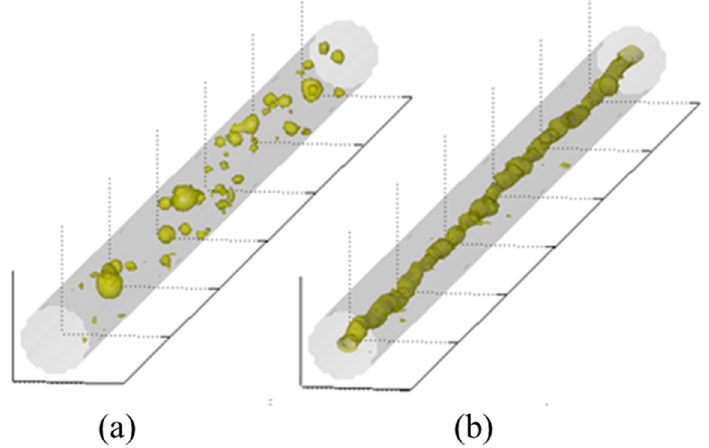
Figure 7. Tomographic wire-mesh data in a dispersed bubbly flow with ( J G ) = 0.5 m/s and ( J L ) = 1.5 m/s. ( a ) Dispersed bubble at the input and ( b ) gas vortex inside the cyclonic chamber.